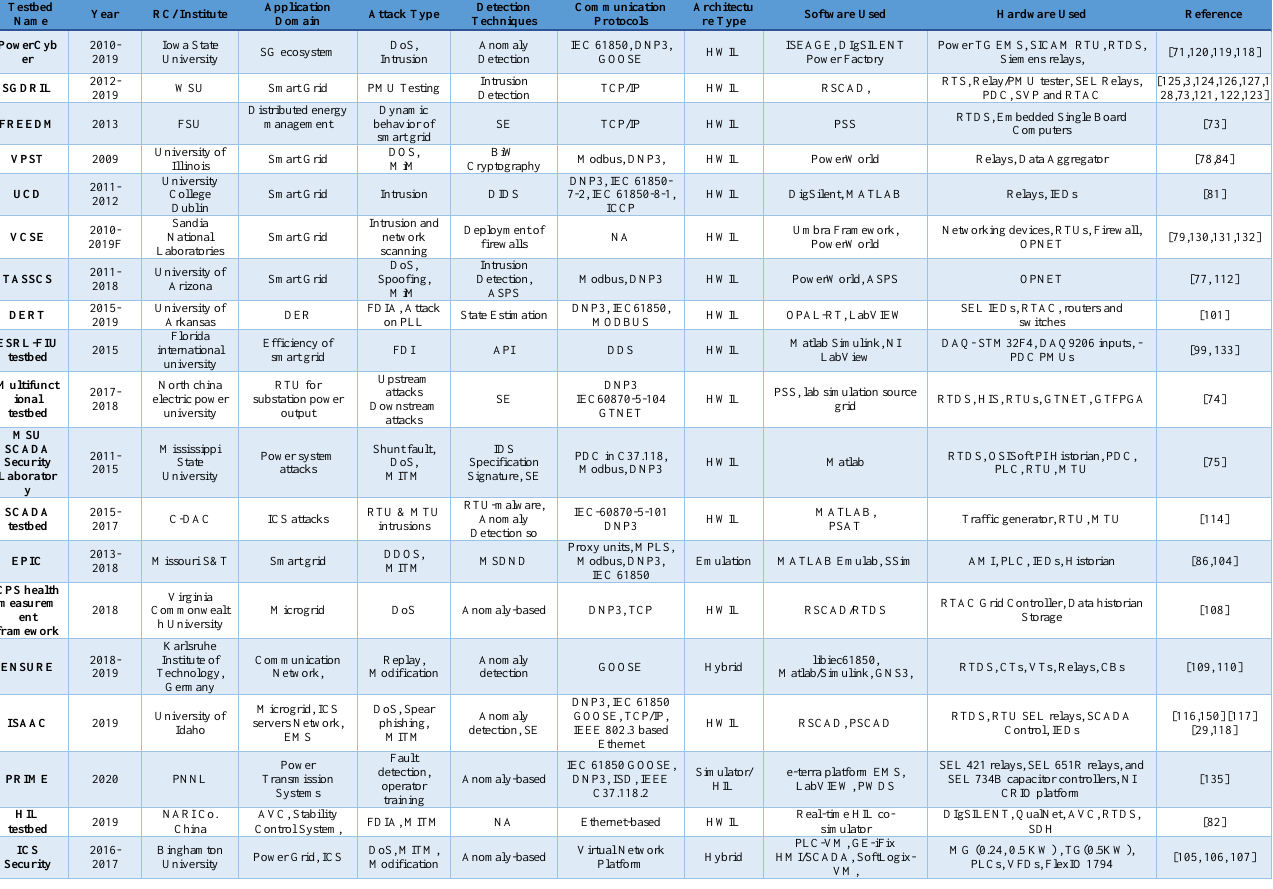
Table 2. Taxonomy of existing cyber-physical smart grid